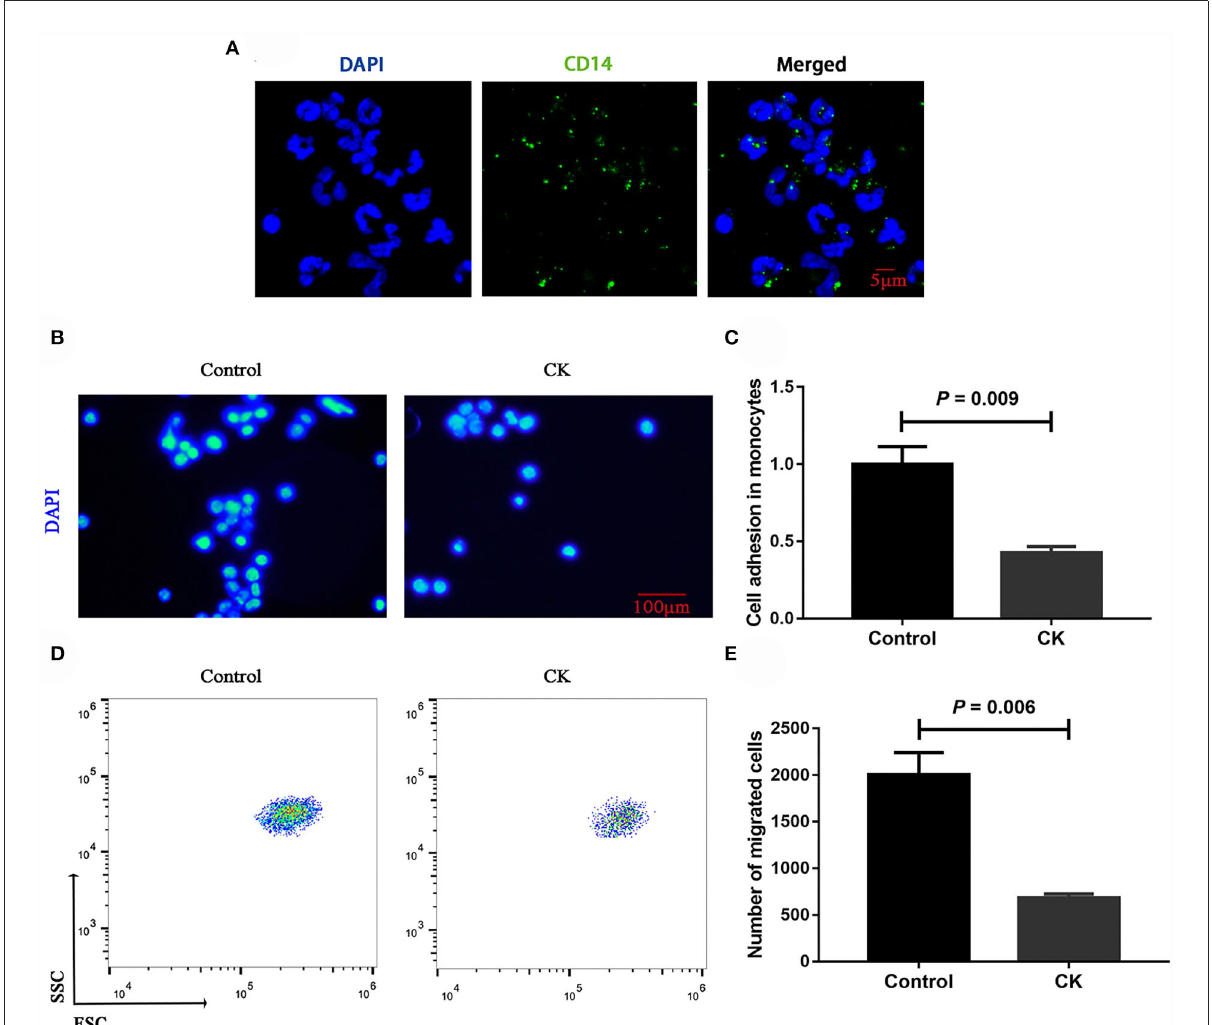
FIGURE1 Migration and adhesion of CD14 + monocytes in healthy cows ( n = 12), and clinically ketotic cows (CK, n = 12). (A) Representative images of CD14 (green), and nuclei (blue), scale bar = 5 µ m. (B,C) Adhesion of monocytes, Nuclei (blue), scale bar = 100 µ m. (D,E) Migration of monocytes. Data were analyzed with paired t -tests and reported as means ± SEM of three independent